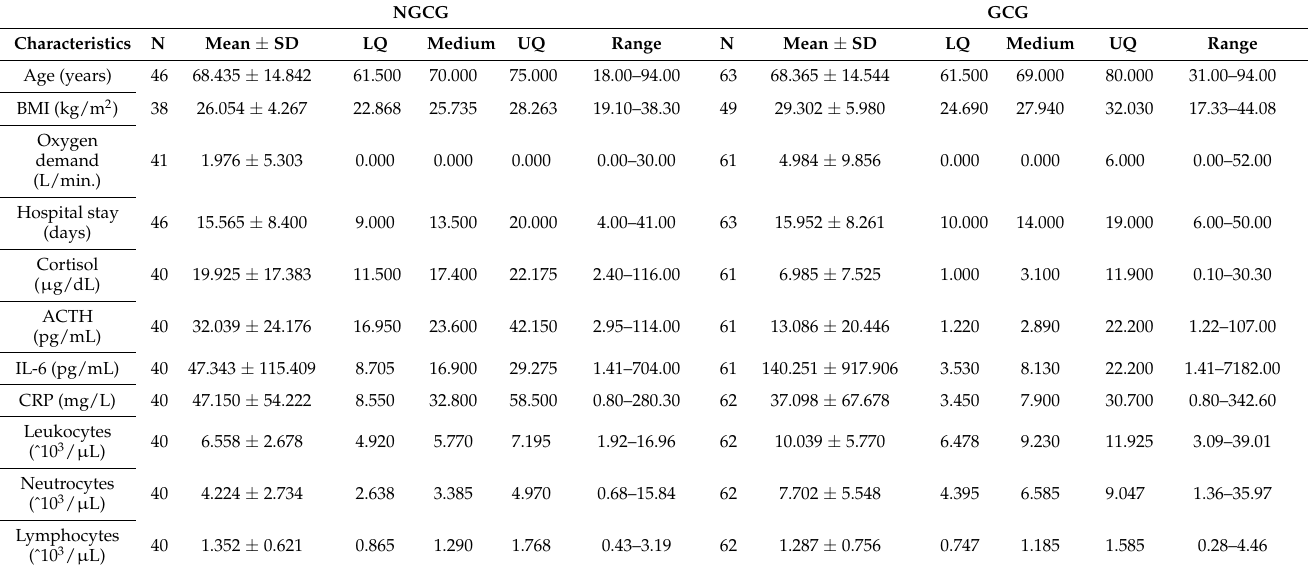
Table 3. Characteristics of the NGCG and the GCG at the time point #3. NGCG